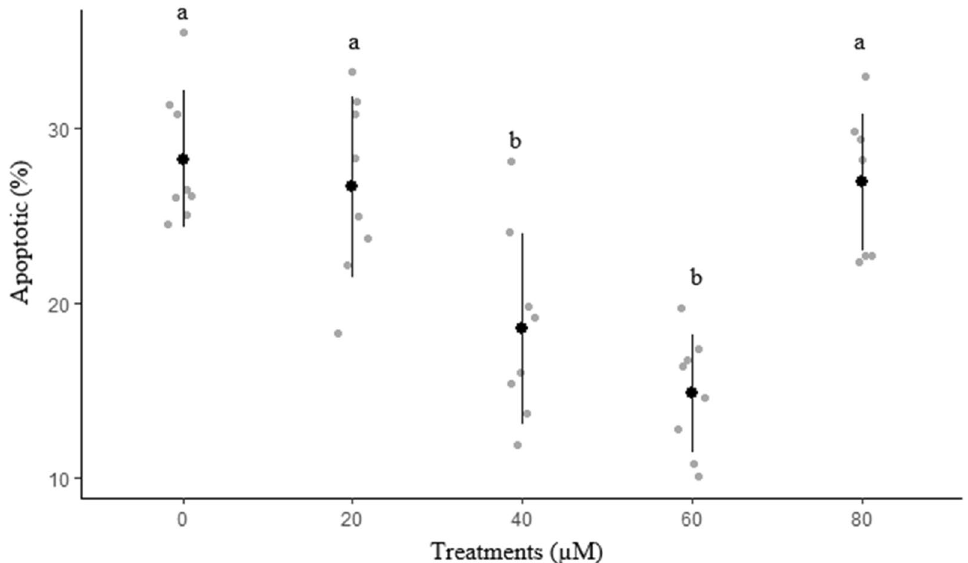
Figure 9. Effect of different levels of rosiglitazone on apoptotic of ram thawed